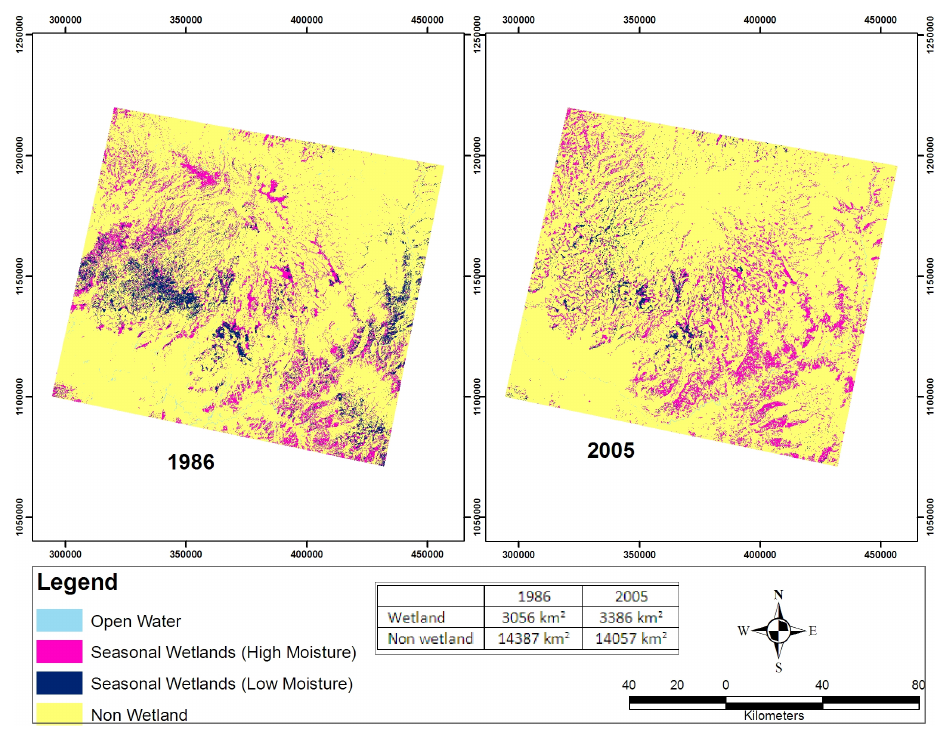
Fig. 4. Spatial distribution of wetland and non wetland.